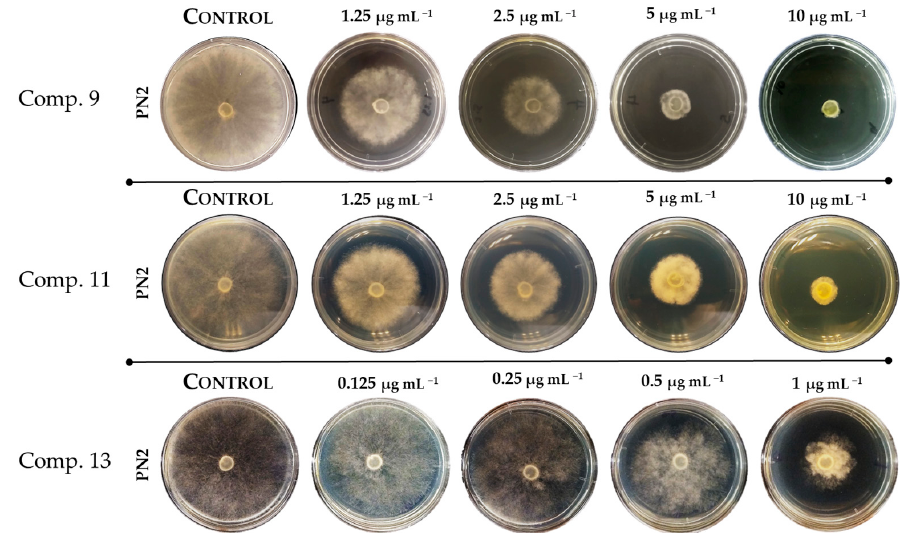
Figure 3. Effect of 2-allylphenol derivatives on the mycelial growth of B. cinerea in solid PDA medium (Difco Potato Dextrose Agar). These images show the effect on hyphae growth from the multiresistant strain of B. cinerea (PN2) in the presence of different concentrations of compounds ( 9 ), ( 11 ) , and ( 13 ). Growth percentage inhibition (%I) was calculated for each concentration, and the IC 50 values (concentration causing 50% inhibition of mycelial growth) were obtained from fitting %I versus compound curves to a dose-response equation (see Section 3). IC 50 values obtained for all assayed compounds are given in Table 1. Table 1. IC 50 values for the in vitro inhibition of the mycelial growth of B. cinerea obtained for 2- allylphenol and its derivatives. These values were estimated by measuring mycelium growth after 48 h of incubation.